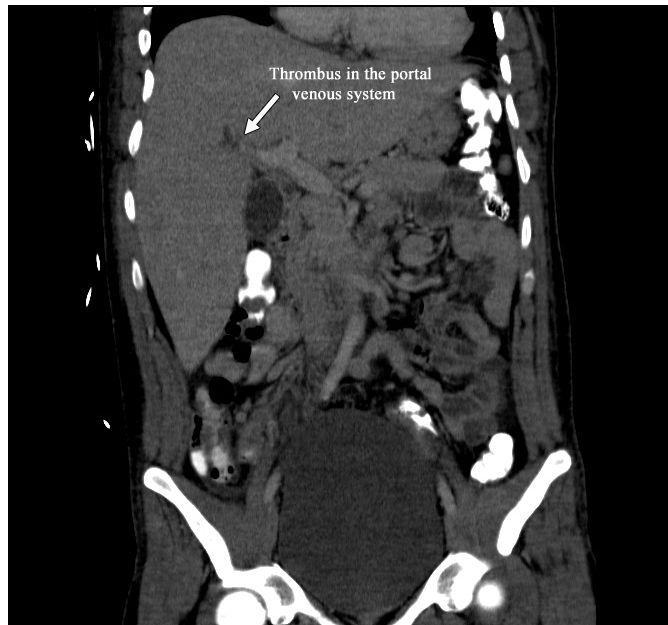
Figure. Computed tomography demonstrating a thrombus in the portal vein and therefore